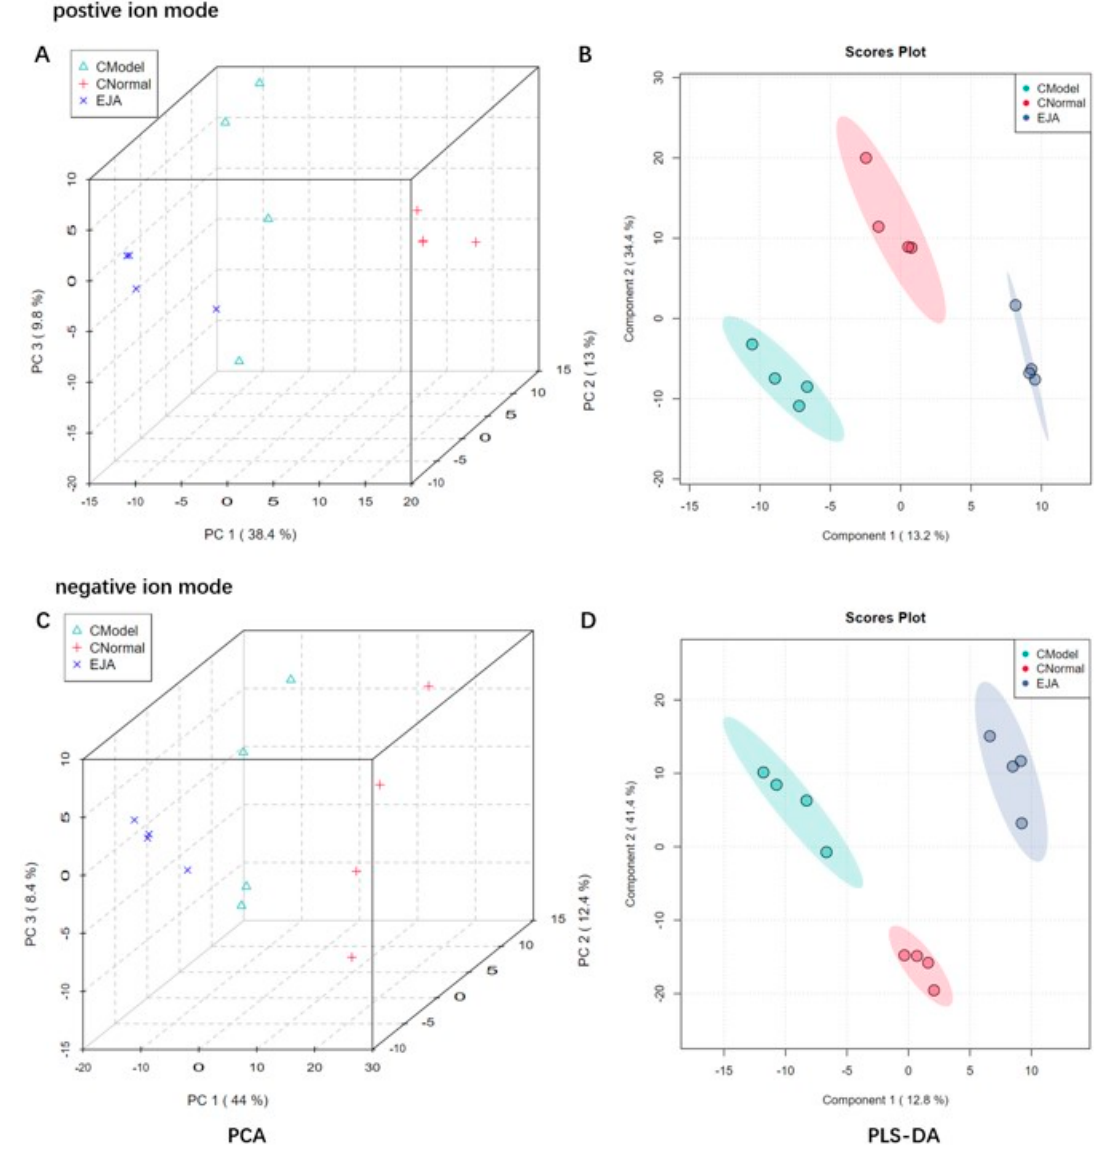
Figure 4. Discrimination of plasma metabolic profiles in normal group (CNormal), model group (CModel), and EJA administered group. Plots of PCA scores ( A ) and PLS-DA scores; ( B ) in positive ion mode; Plots of PCA scores; ( C ) PLS-DA scores; and ( D ) in negative ion mode.